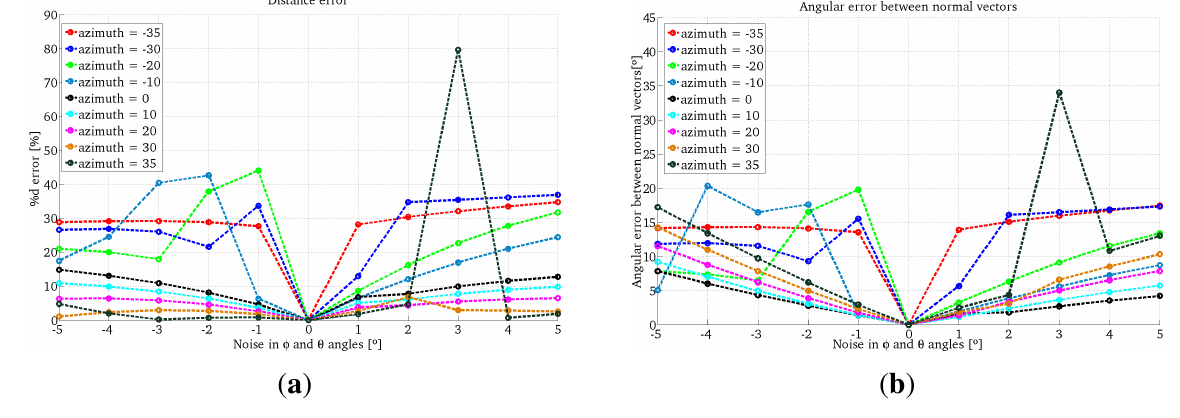
Figure 7. Simulation results using One-endpoint method with one conic projection. ( a ) Error in depth; ( b ) Error in the surface orientation.